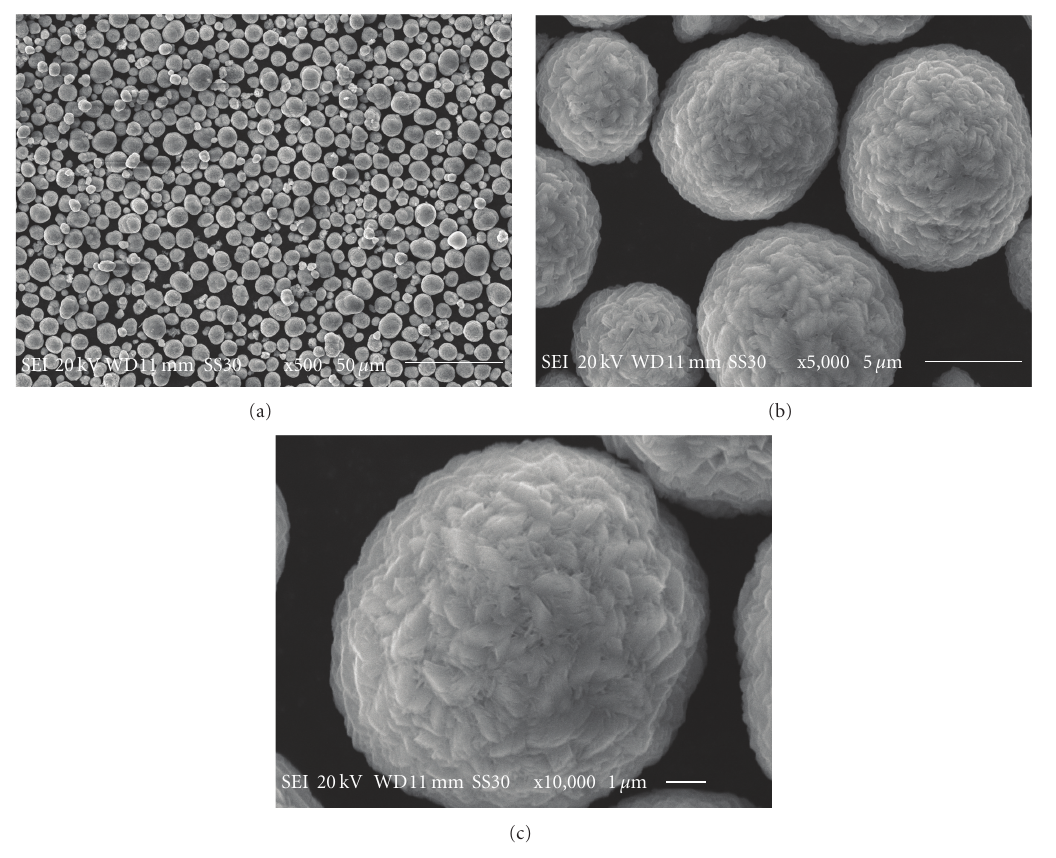
Figure 4: SEM of [Ni 0 . 5 Mn 0 . 3 Co 0 . 2 ](OH) 2 precursor at di ff erent magnifications (a) 500X, (b) 5000X, and (c) 10,000X.